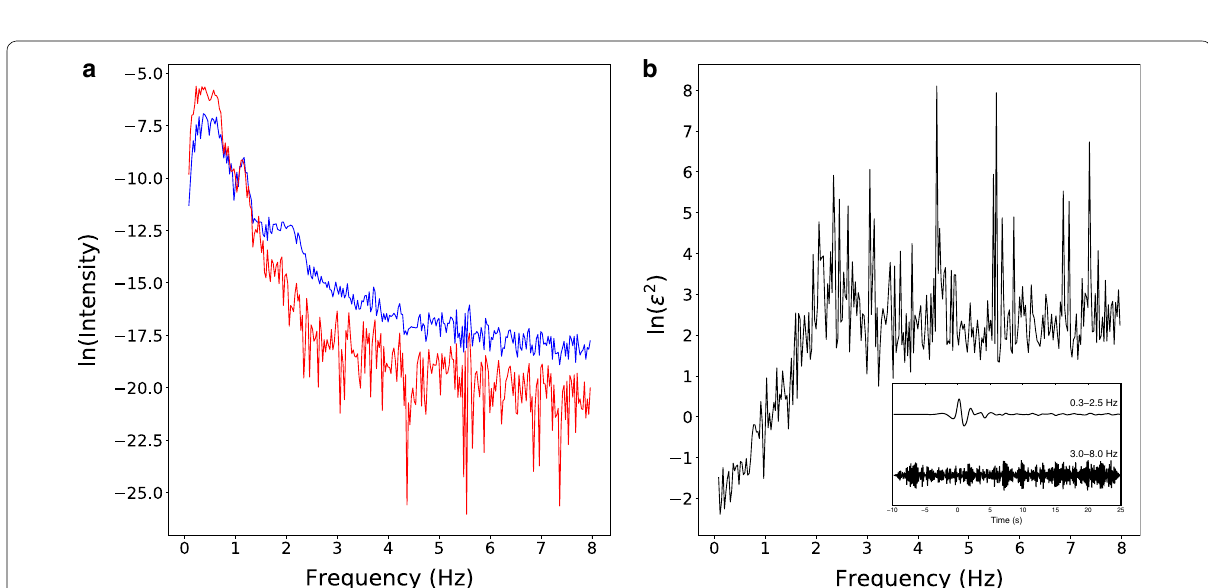
Fig. 5 a Plot of logarithm of squared amplitude spectra of the stacked (red) and residual (blue) waveforms for the event in Fig. 3. b Plot of logarithm of the ratio ( ε 2 ) of fluctuating and coherent intensities against